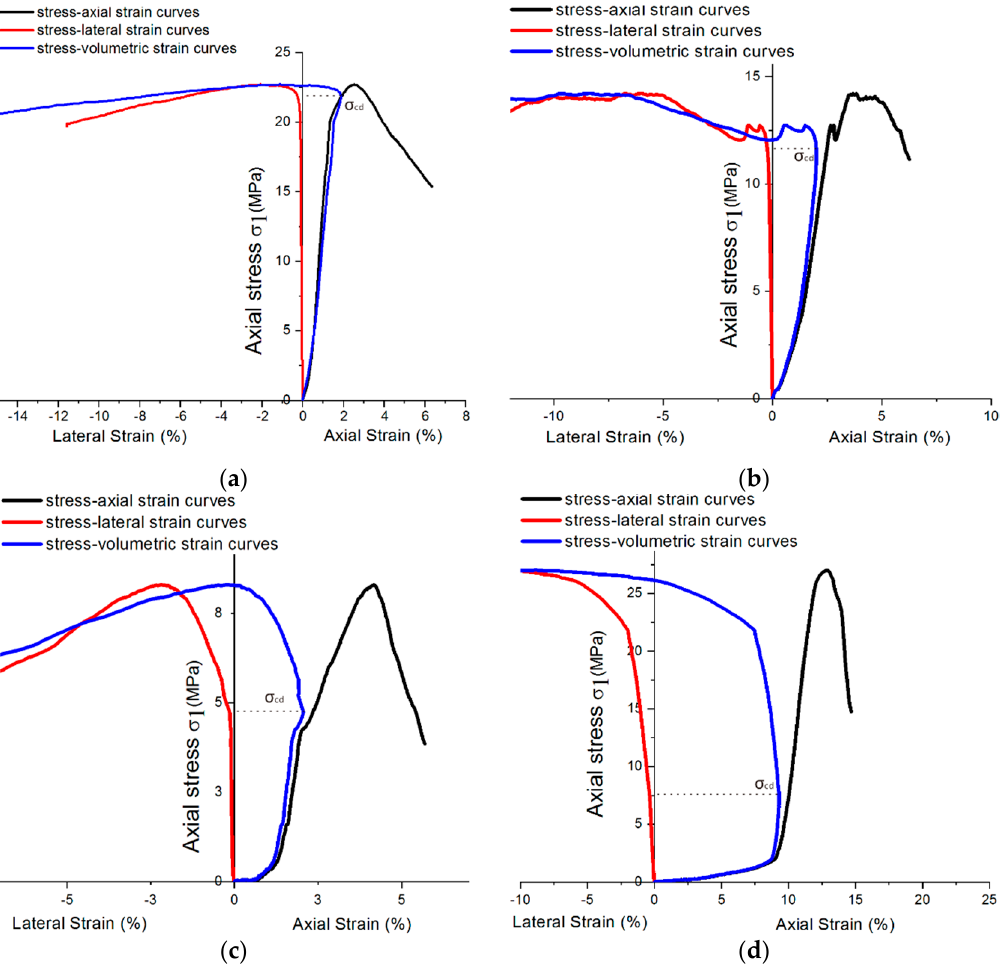
Figure 16. Stress–strain diagram showing σ cd of 12-h curing age samples mixing with different sulfate concentrations: ( a ) 0% concentration; ( b ) 2% concentration; ( c ) 5% concentration; and ( d ) 10% concentration.